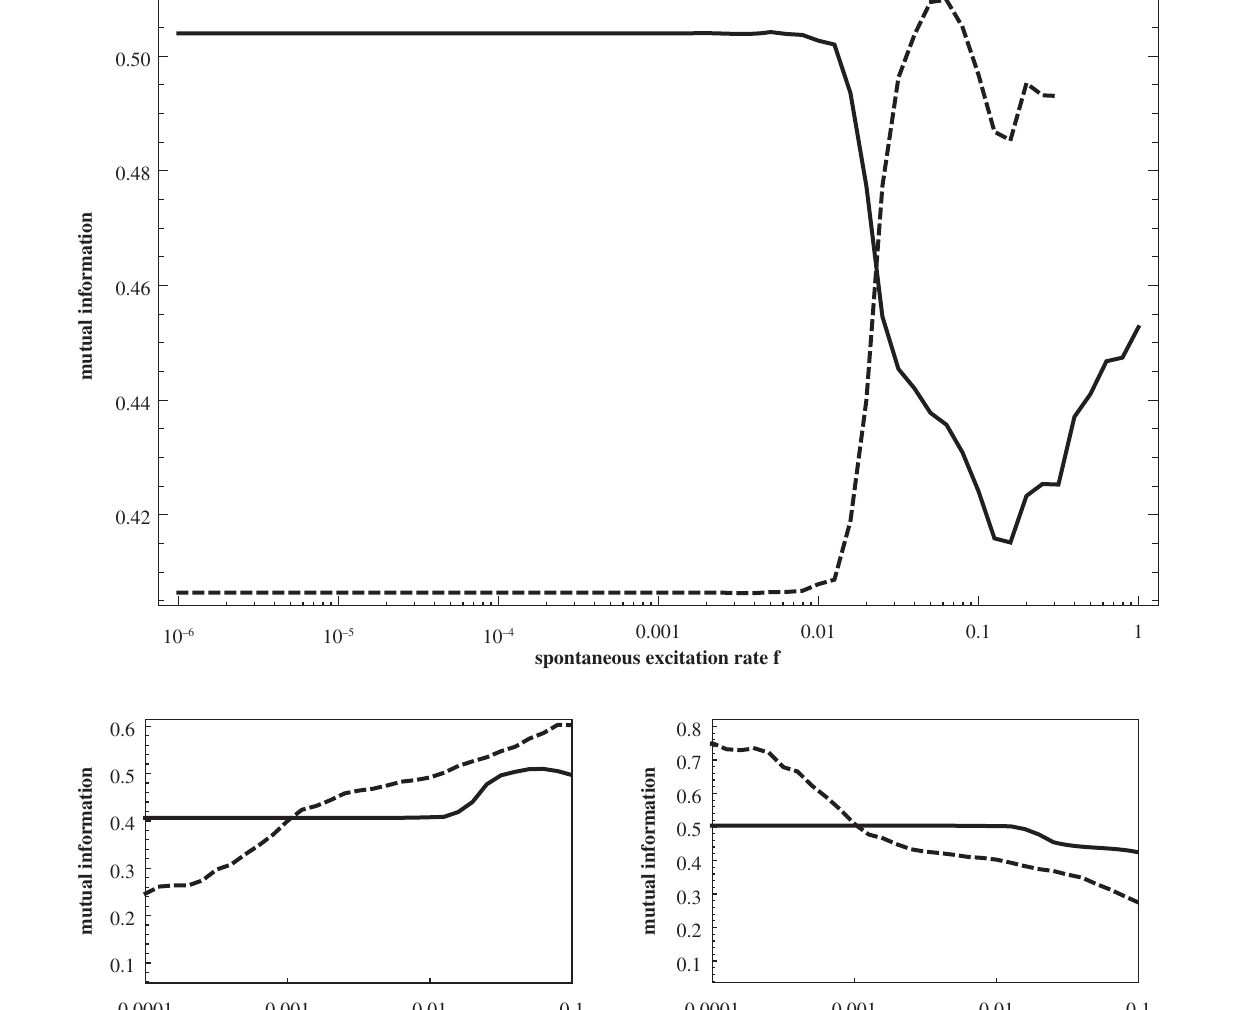
with modularity ij